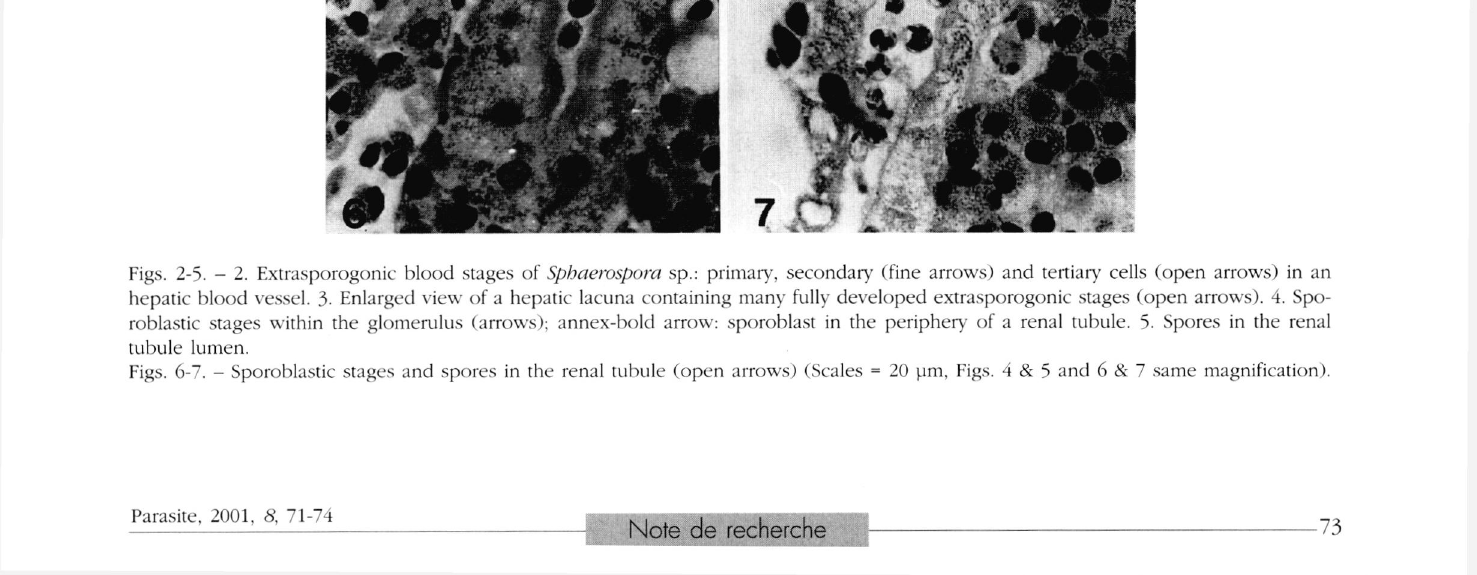
Parasite, 2001, 8,